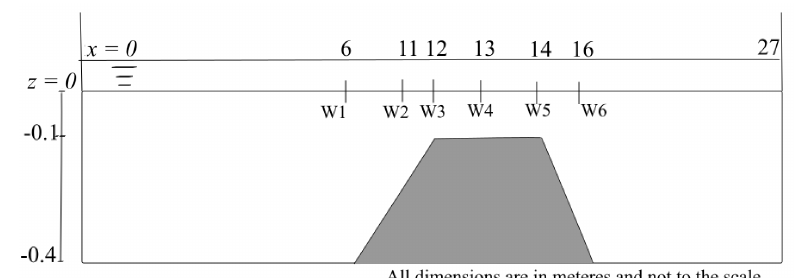
Figure 5. Numerical wave tank setup for simulating the experiments performed by Beji and Battjes